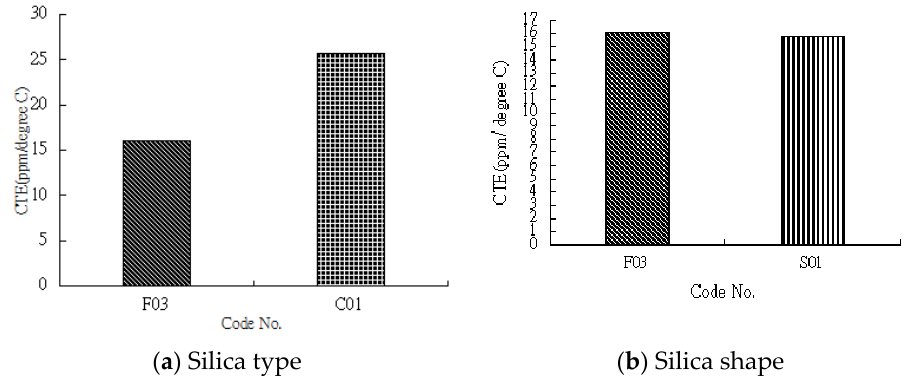
Figure 9. CTE of EMCs with silica fillers of different types and shapes.